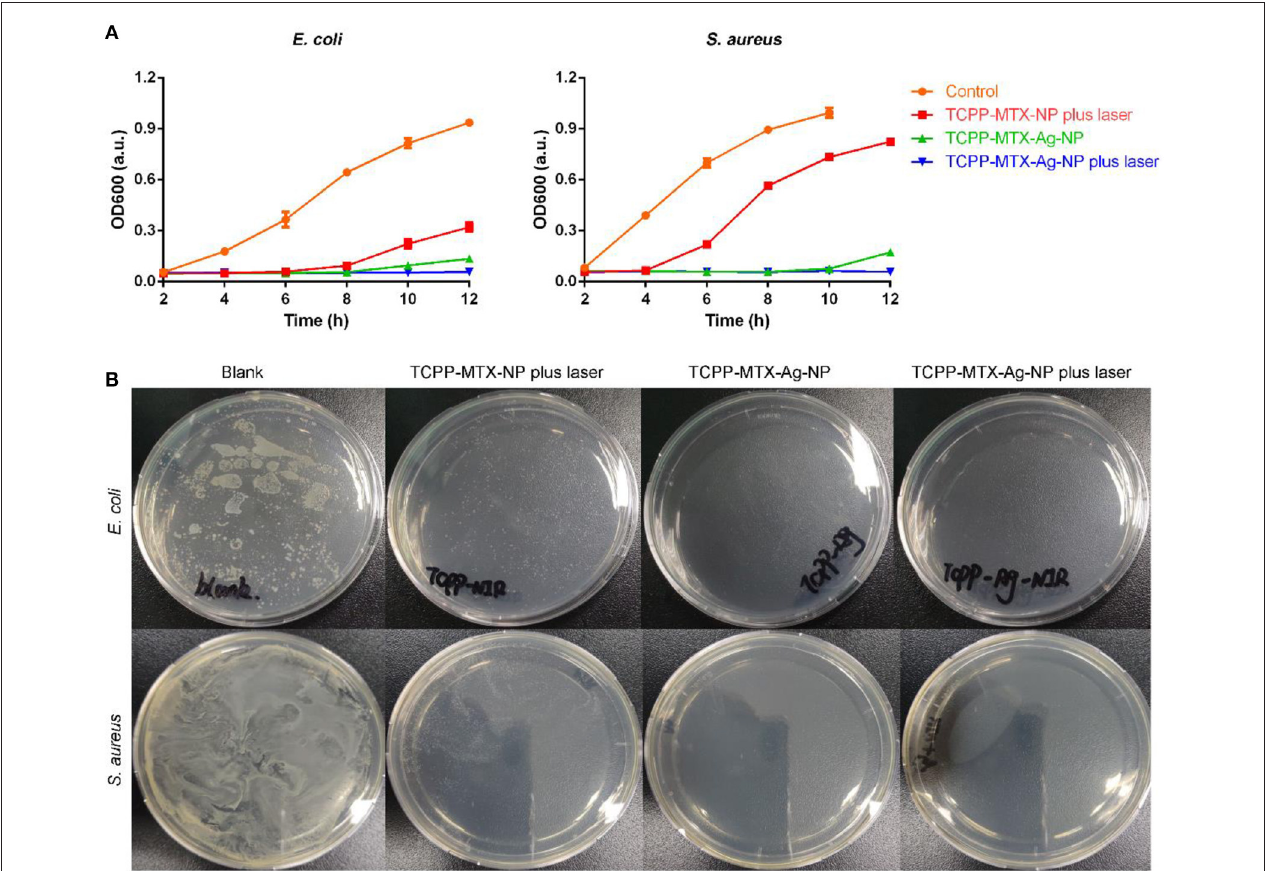
FIGURE 4 | The antibacterial activity of the supermolecular nano-carriers. (A) The bacterial growth profiles; (B) The bacterial colony formation in the LB plate.